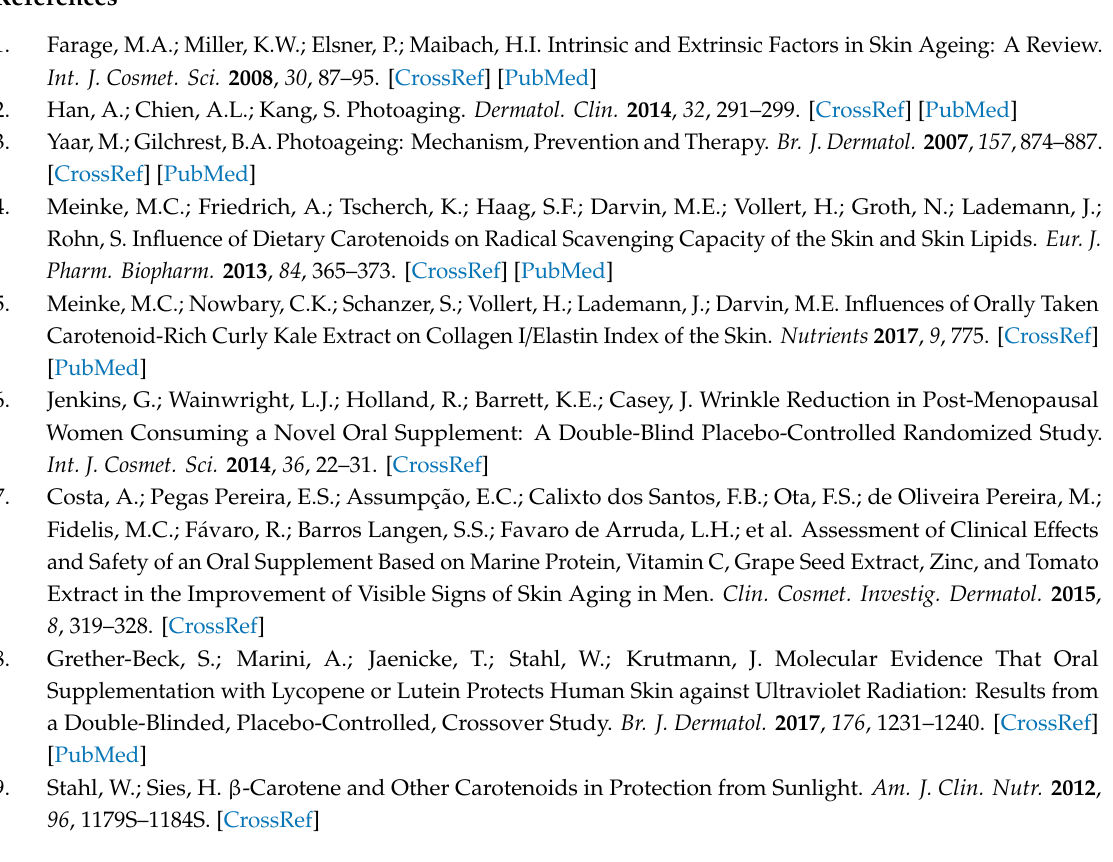
Table S1: 24-h reported dietary